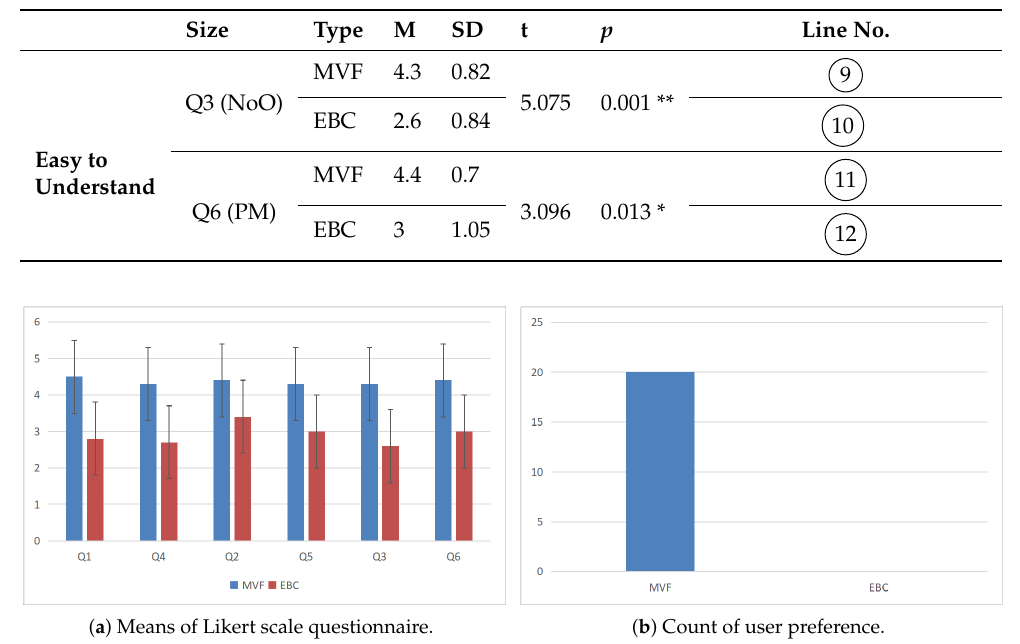
Figure 8. Results of task completion time in seconds. Error bars indicate the standard deviation of the measured